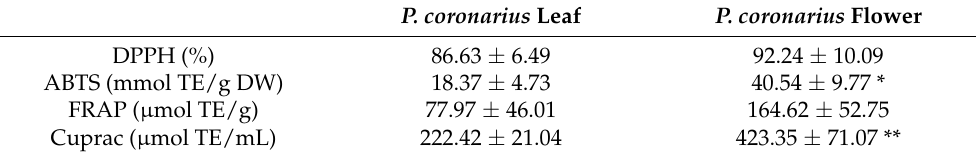
Table 3. Antioxidant activity of P. coronarius leaf and flower evaluated by different methods.